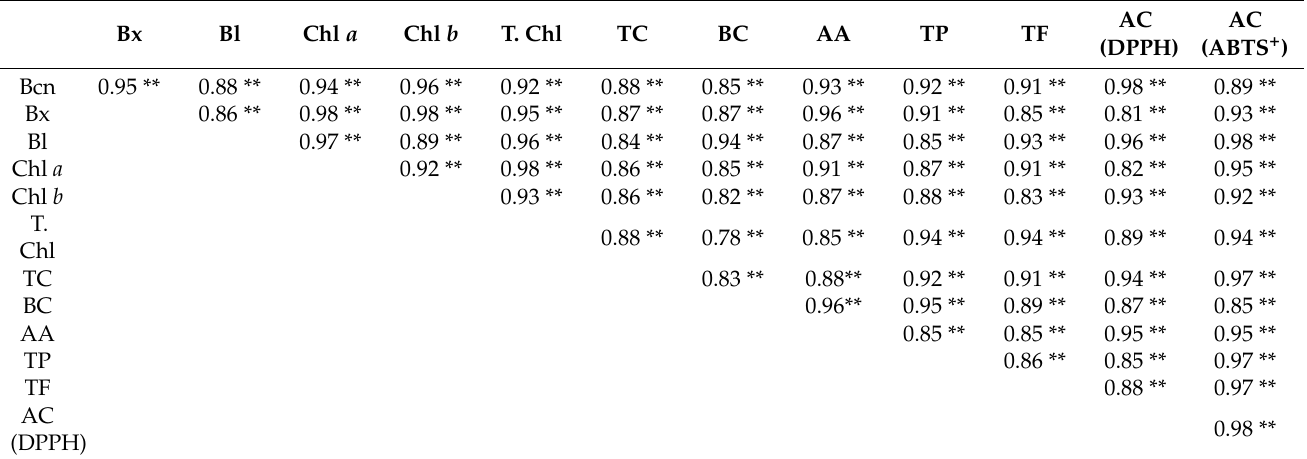
Table 1. The correlation coefficients for phytopigments, antioxidant capacity, and phytochemicals in drought-resistant vegetable